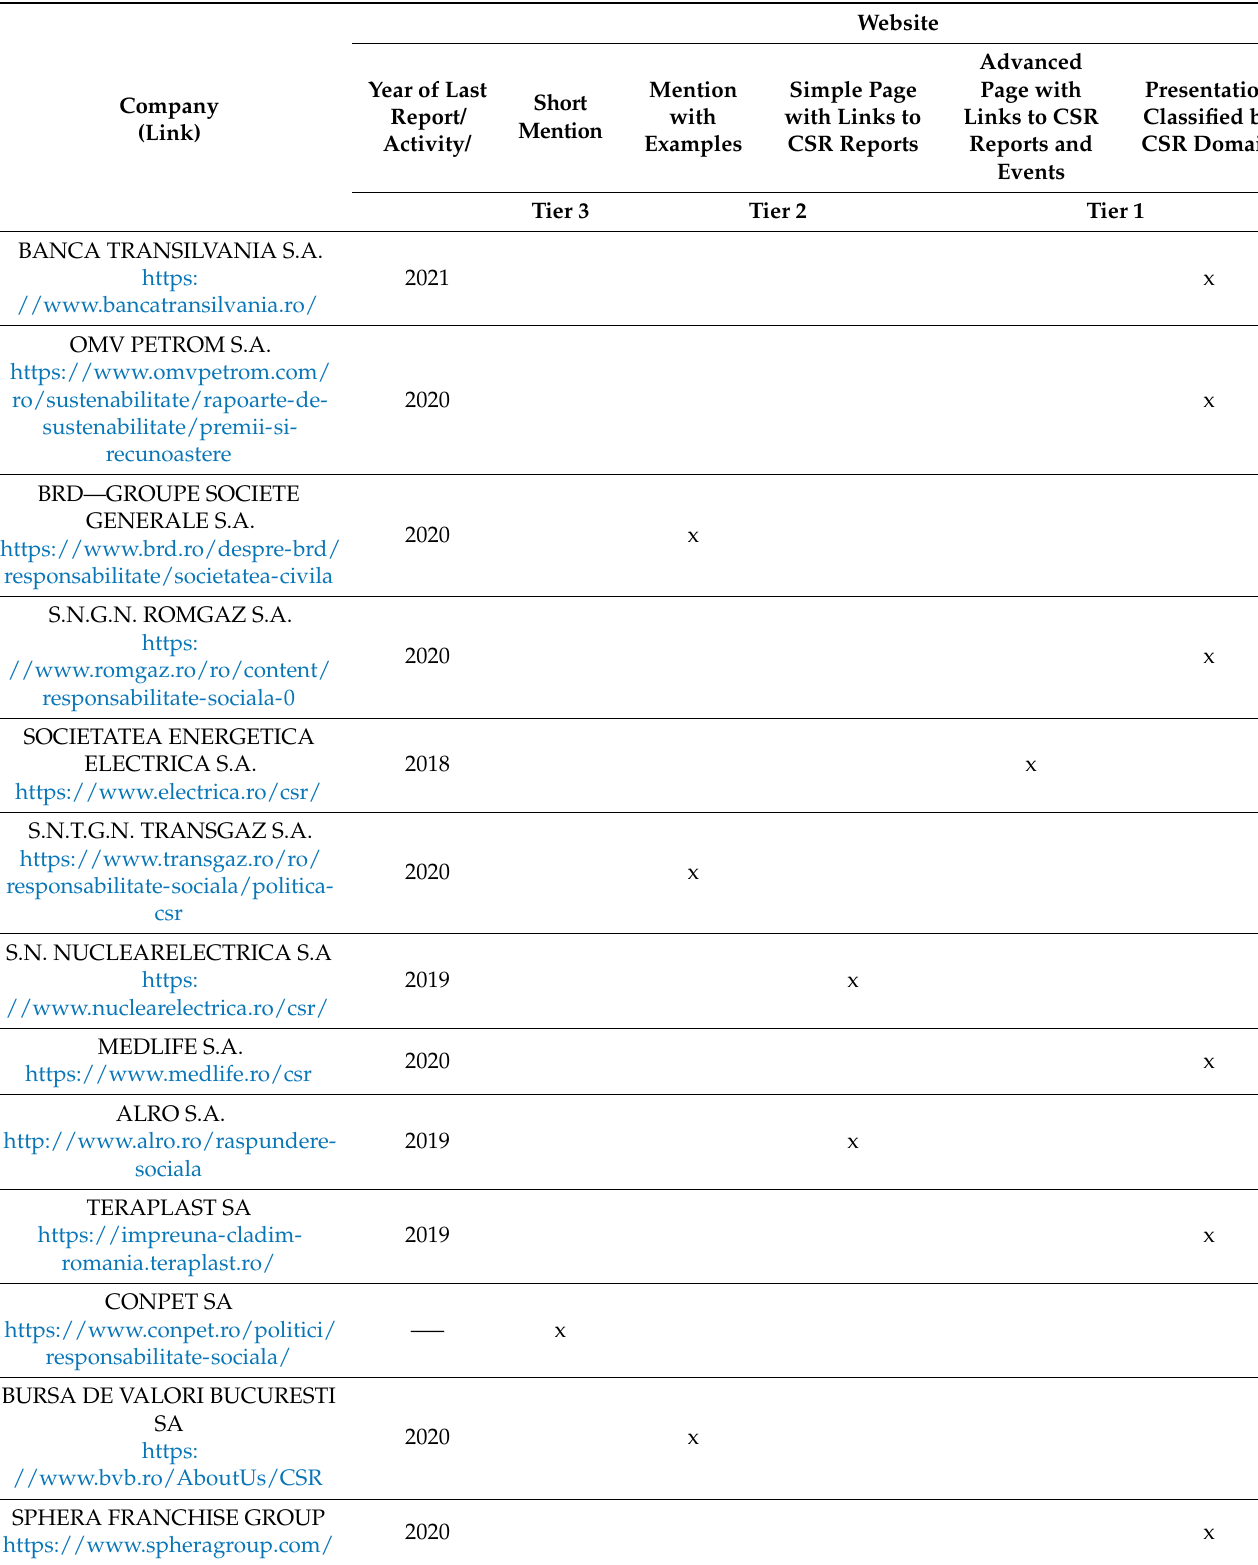
Table 3. Analysis of CSR information presented on companies’